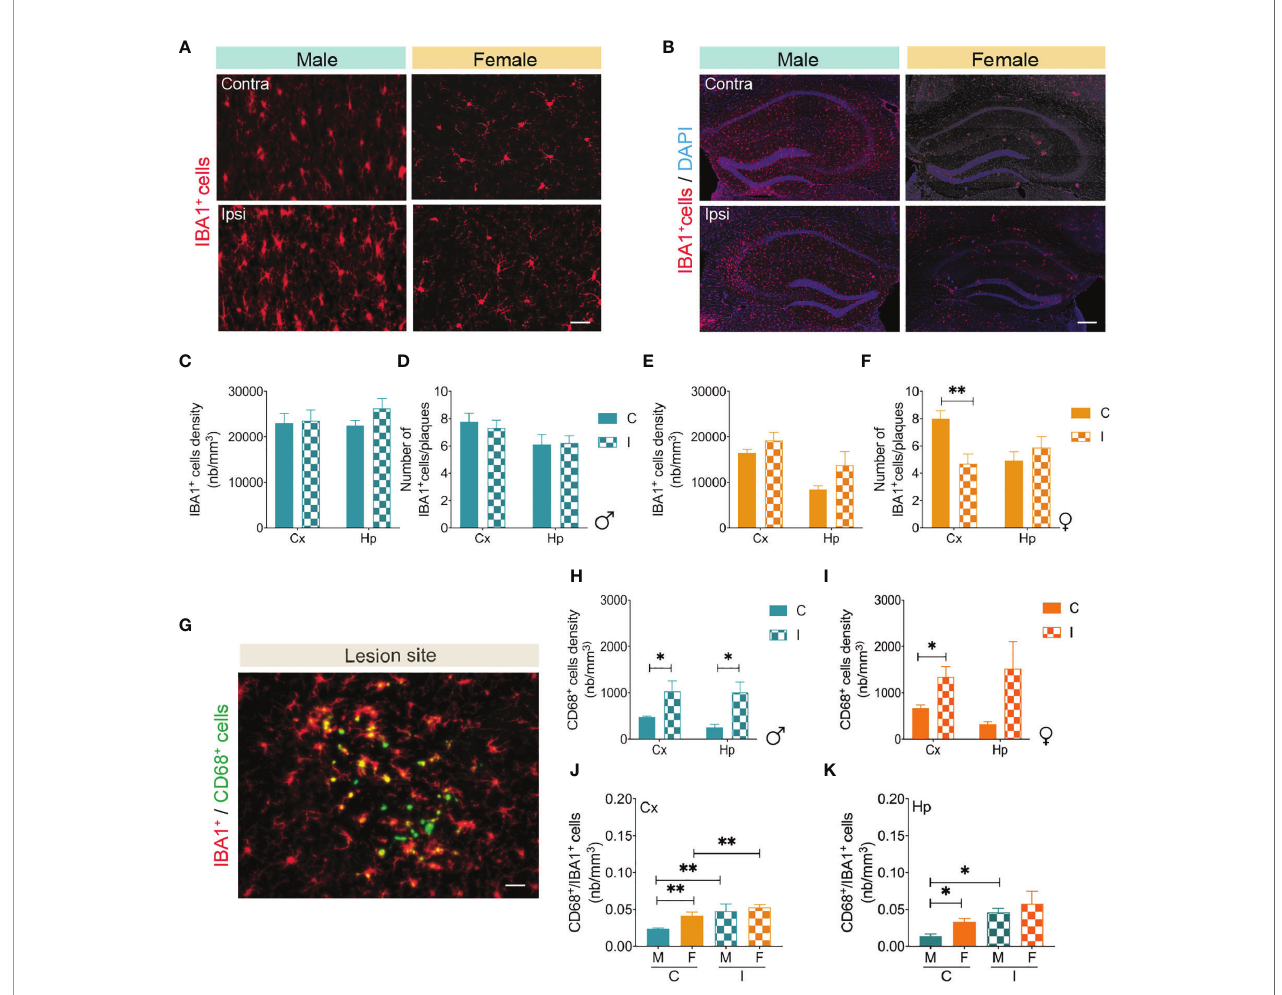
FIGURE 6 | Multifocal microinfarcts induce microglial cell activation. Representative fl uorescent images of IBA1 immunolabeled microglia (red) in the (A) cortex and (B) hippocampus of MO-operated male and female APP/PS1 mice. Immuno fl uorescence combined to stereological analysis shows that (C) the density of IBA1 + cells in the cortex and hippocampus, and (D) the number of IBA1 + cells surrounding A b plaques remains unchanged in the brain of MO-operated male APP/PS1 mice. Immuno fl uorescence combined to stereological analysis shows that (E) the density of IBA1 + cells in the cortex and hippocampus of MO-operated male APP/PS1 mice remains unchanged, and while (F) the number of IBA1 + cells surrounding A b plaques decreases in the cortex of MO-operated female APP/PS1 mice, it remains unchanged in the hippocampus. (G) A representative fl uorescent image of IBA1 immunolabeled microglia (red) and CD68 (green) at the lesion site in MO-operated male WT mice show that microglia adopt a phagocytic state (IBA1 + /CD68 + ). A population of IBA1 - /CD68 + cells phagocytic cells are also present. Immuno fl uorescence combined to stereological analysis shows that the density of CD68 + cells in the ipsilateral hemisphere of (H) MO-operated male APP/PS1 mice, and (I) MO-operated female APP/PS1 mice. Immuno fl uorescence combined to stereological analysis indicates that (J) the density of IBA1 + /CD68 + cells is higher in the contralateral cortex of MO-operated female APP/PS1 mice compared to the contralateral cortex of MO-operated male APP/PS1 mice and remains higher in the ipsilateral cortex of MO- operated female compared to the ipsilateral cortex of MO-operated male APP/PS1 mice. Immuno fl uorescence combined to stereological analysis indicates that (K) the density of IBA1 + /CD68 + cells is increased in the contralateral hippocampus of MO-operated female APP/PS1 mice compared to MO-operated male APP/PS1 mice, as well as in the ipsilateral hippocampus of MO-operated male APP/PS1 mice compared to the contralateral hippocampus of MO-operated male APP/PS1 mice. Data are mean ± SEM (n = 5-10 animals/group). *P < 0.05/**P < 0.01 compared to ipsilateral or contralateral hemisphere of MO-operated male and female APP/PS1 mice (two- tailed unpaired t-test). Scale bar = 250